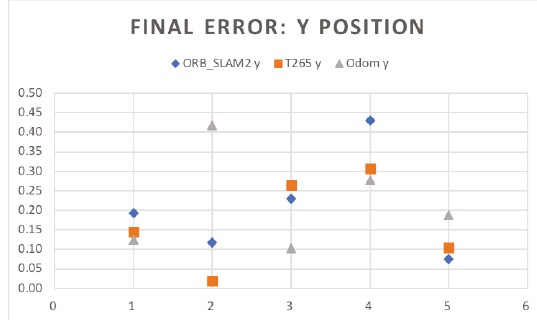
Figure 19. Indoor tests scenario 2. Test 1. Trial 1. Final error Y position.